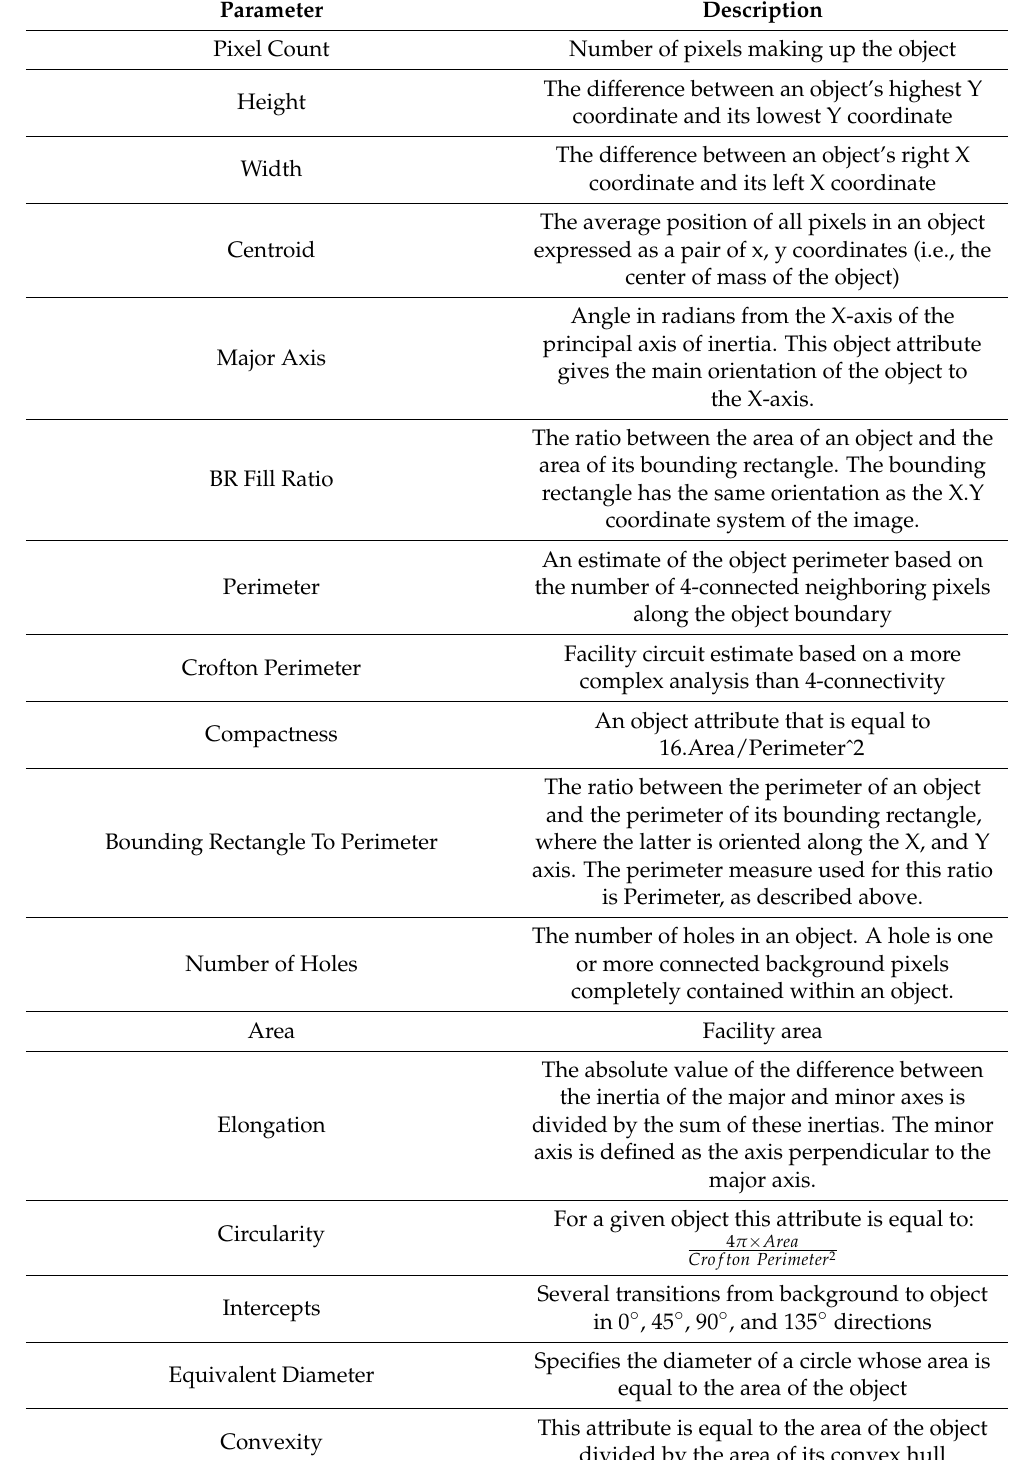
Table 5. Two-dimensional parameters obtained as a result of the automated image analysis using Aphelion